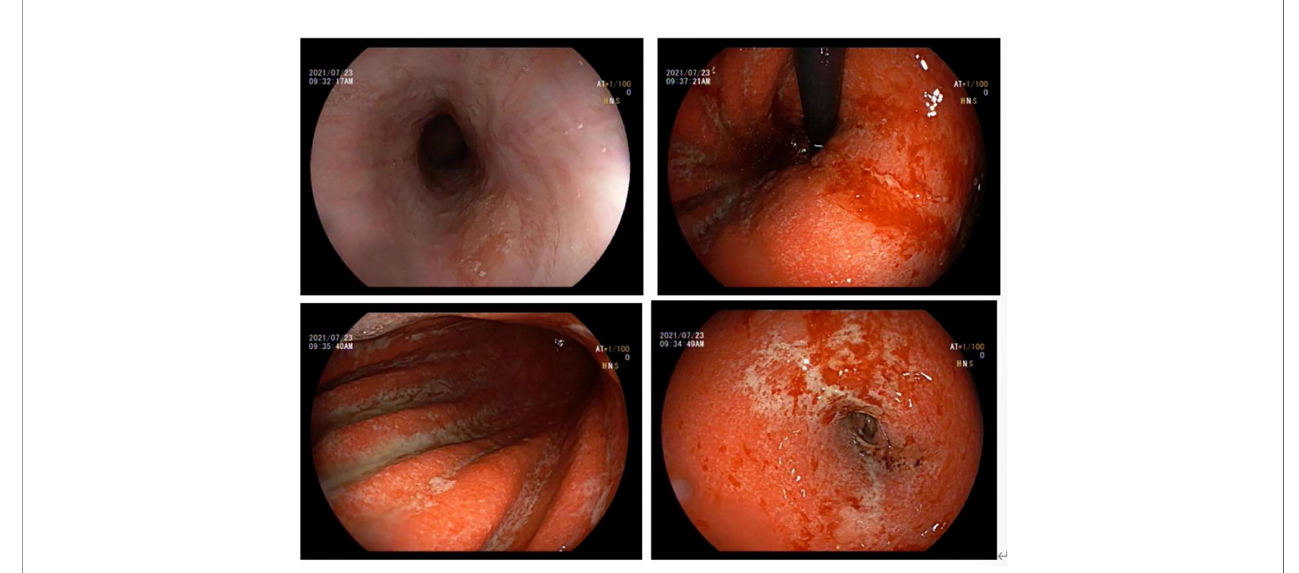
FIGURE 2 | Gastroscopy of acute erosive hemorrhagic gastritis after regular treatment (day 511). The esophageal mucosa was smooth with good contraction, and his EGD showed the whole gastric mucosa was hypermic and edematous, with diffuse erosion of white moss and active oozing of blood. Small fl aps of mucosal necrosis and stripping could be seen at the posterior wall of the gastric antrum, which showed a relatively more healed condition than seen in the previous EGD.